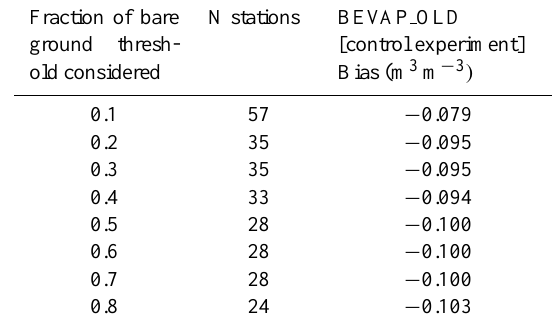
Table 3. Biases between BEVAP OLD (control experiment) and in situ data from the stations of the NRCS-SCAN network in 2010. Fraction of bare ground is used as a filter to compute